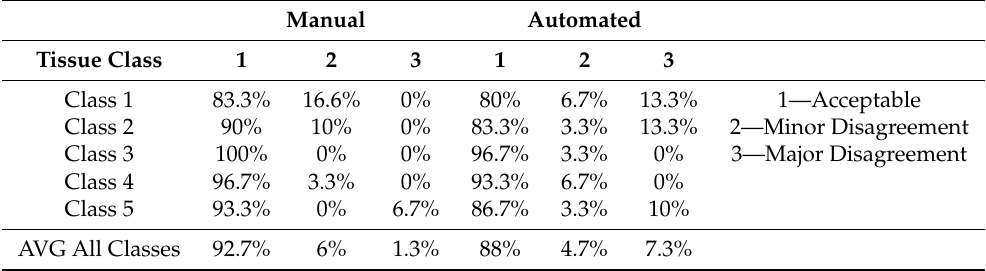
Table 7. A class by class qualitative evaluation of the manual and automatic segmentations by an independent observer on a case